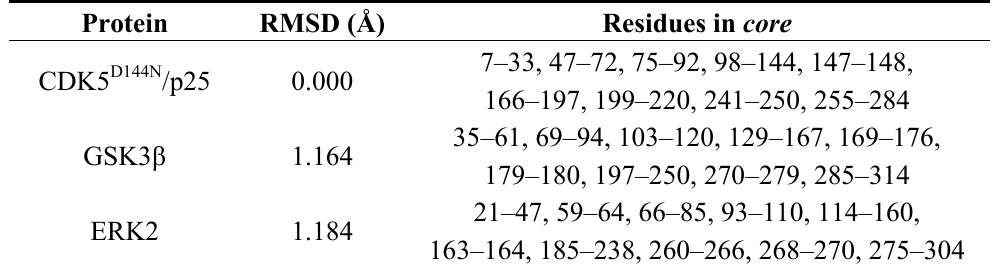
Table 2. RMSD (Å) between the CDK5 D144N /p25 model and the other kinase models studied for the residues within the core .